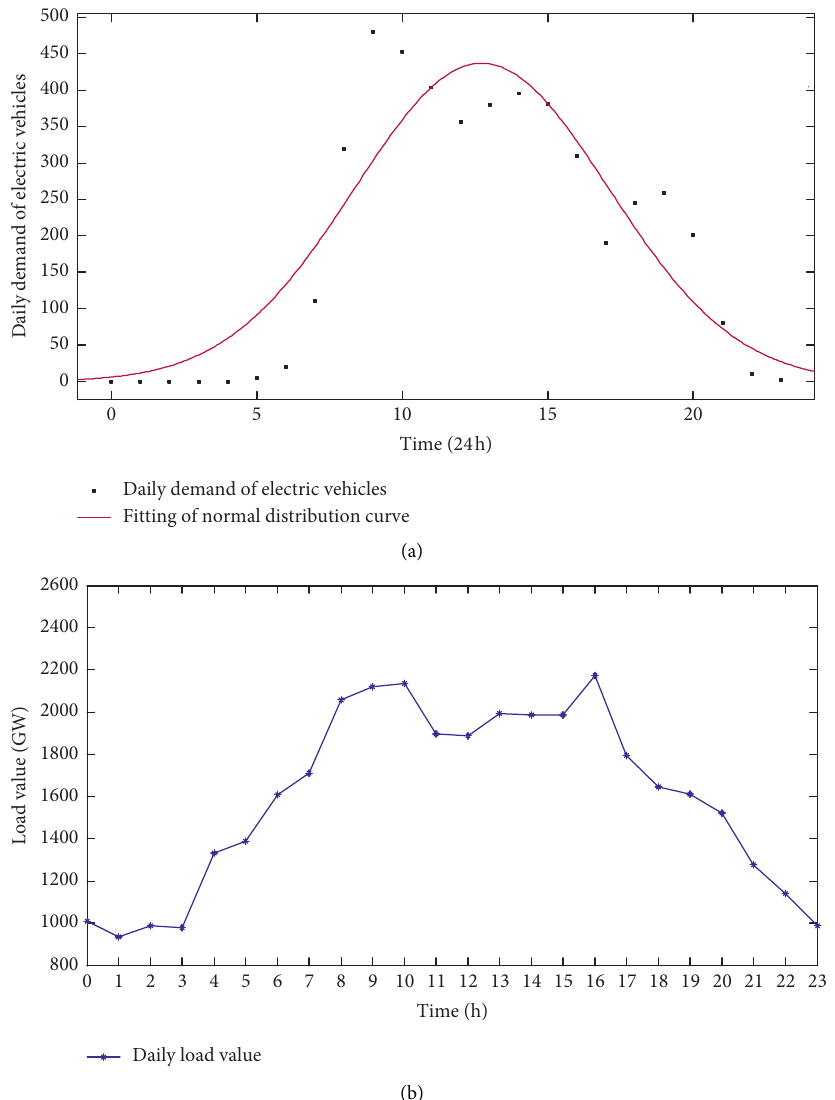
Figure 6: Comparison of daily charging demand of electric vehicles and daily load curves of power grid. (a) Daily demand curve of charged vehicles. (b) Graph of basic daily load curve of power grid.